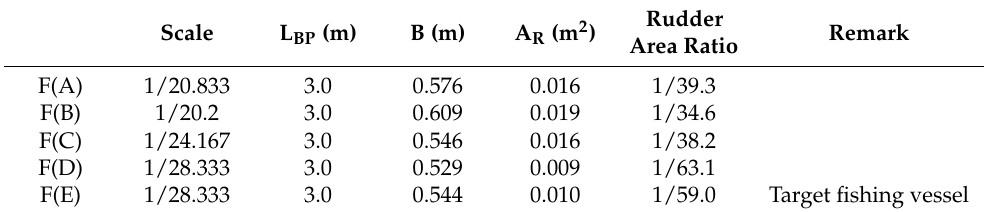
Table 7. Rudder area ratio of model fishing trawlers.